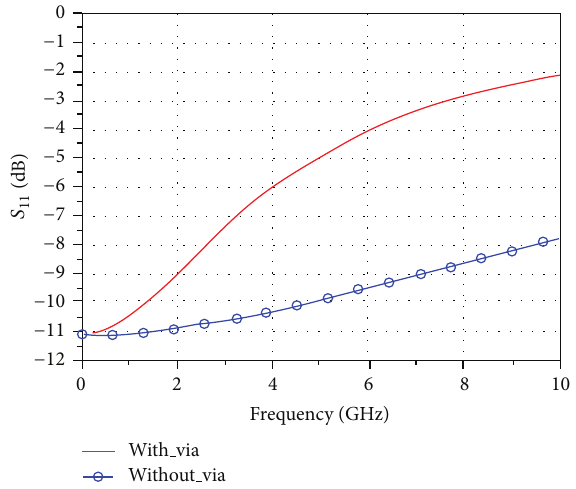
Figure 3: The impact of the via on signal reflection.